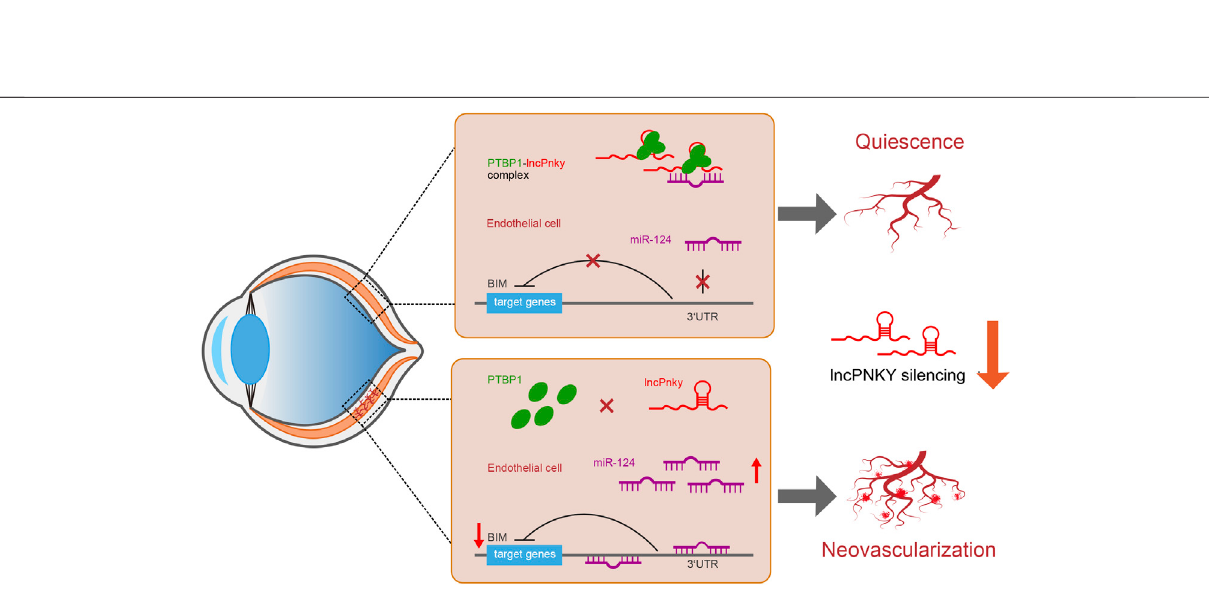
FIGURE9| Schematicillustrationofthemechanismhypothesis.WehypothesizedthatlncRNAPNKYisaninhibitoryfactorforcelldifferentiationandgrowth invivo . WhenPNKYissilenced,thederepressionofmiR-124 restrainstheexpression ofthetarget geneBIM,whichresults indecreased apoptosis, increasedproliferation,and aggravated